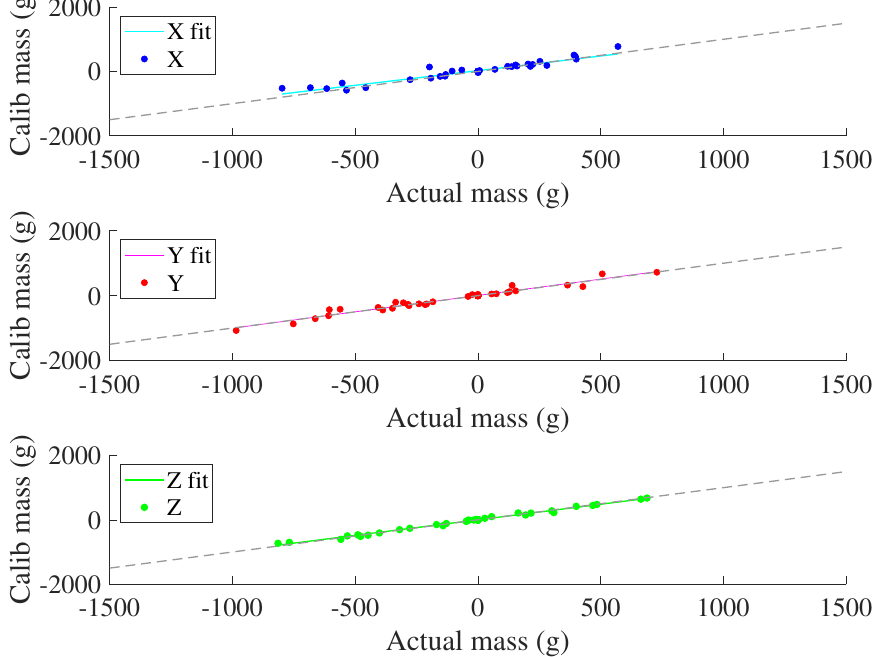
Figure 19. Axial components of actual loading compared with loads predicted by the calibration matrix. The black line indicates ideal estimation matching with actual